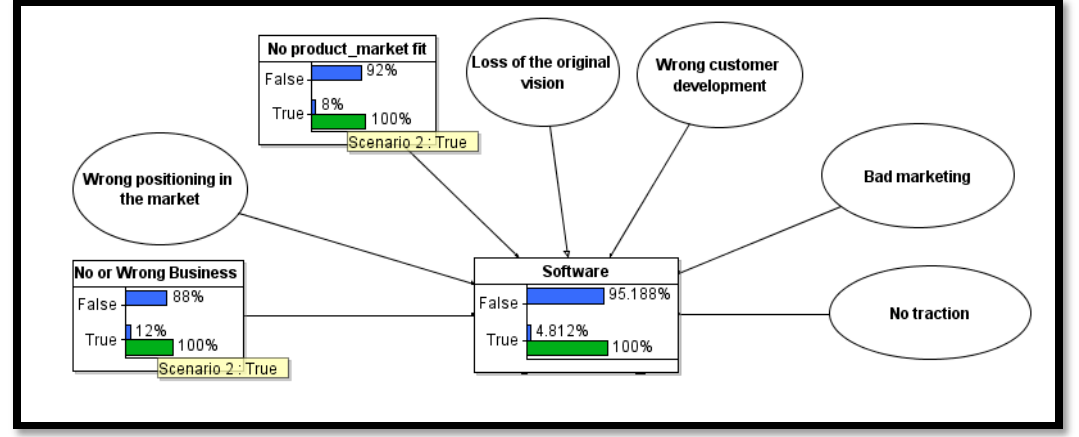
Figure 1. The relationship between the key factor of software failure and its subfactors .